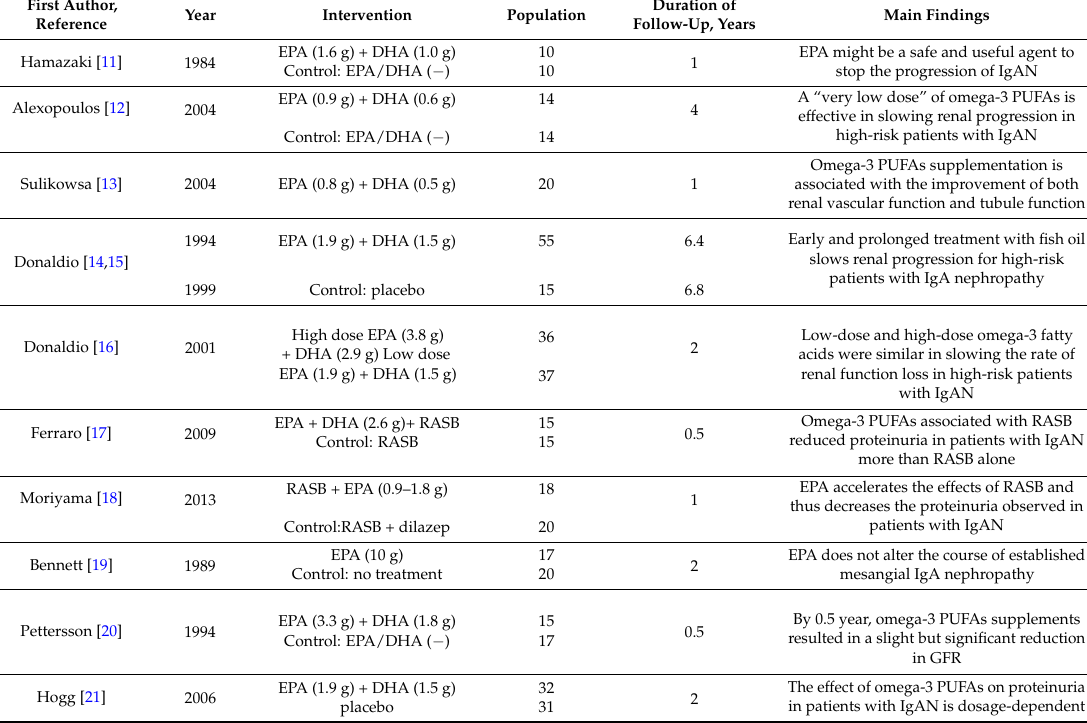
Table 1. Clinical trials evaluating ω -3 polyunsaturated fatty acids (PUFAs) in patients with